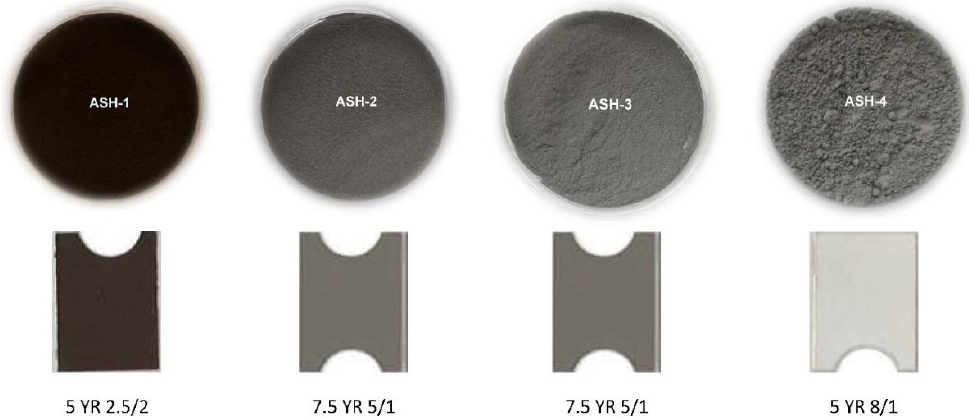
Figure 3. Illustration of ash samples collected from Kontodespoti-Makrimalli area depicting ash colour and corresponding Munsell ® colour code (modified from [28]).